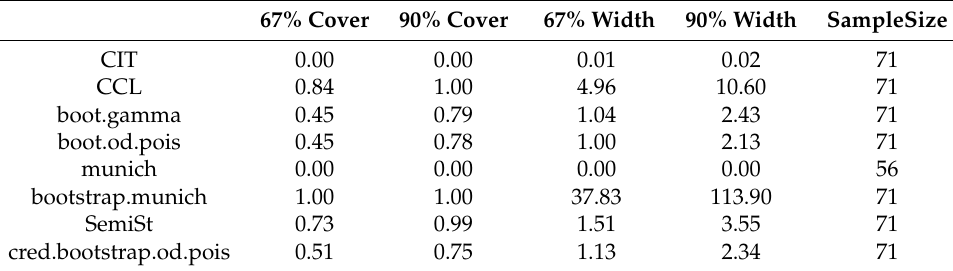
Table 12. Coverage and average width from the commercial auto